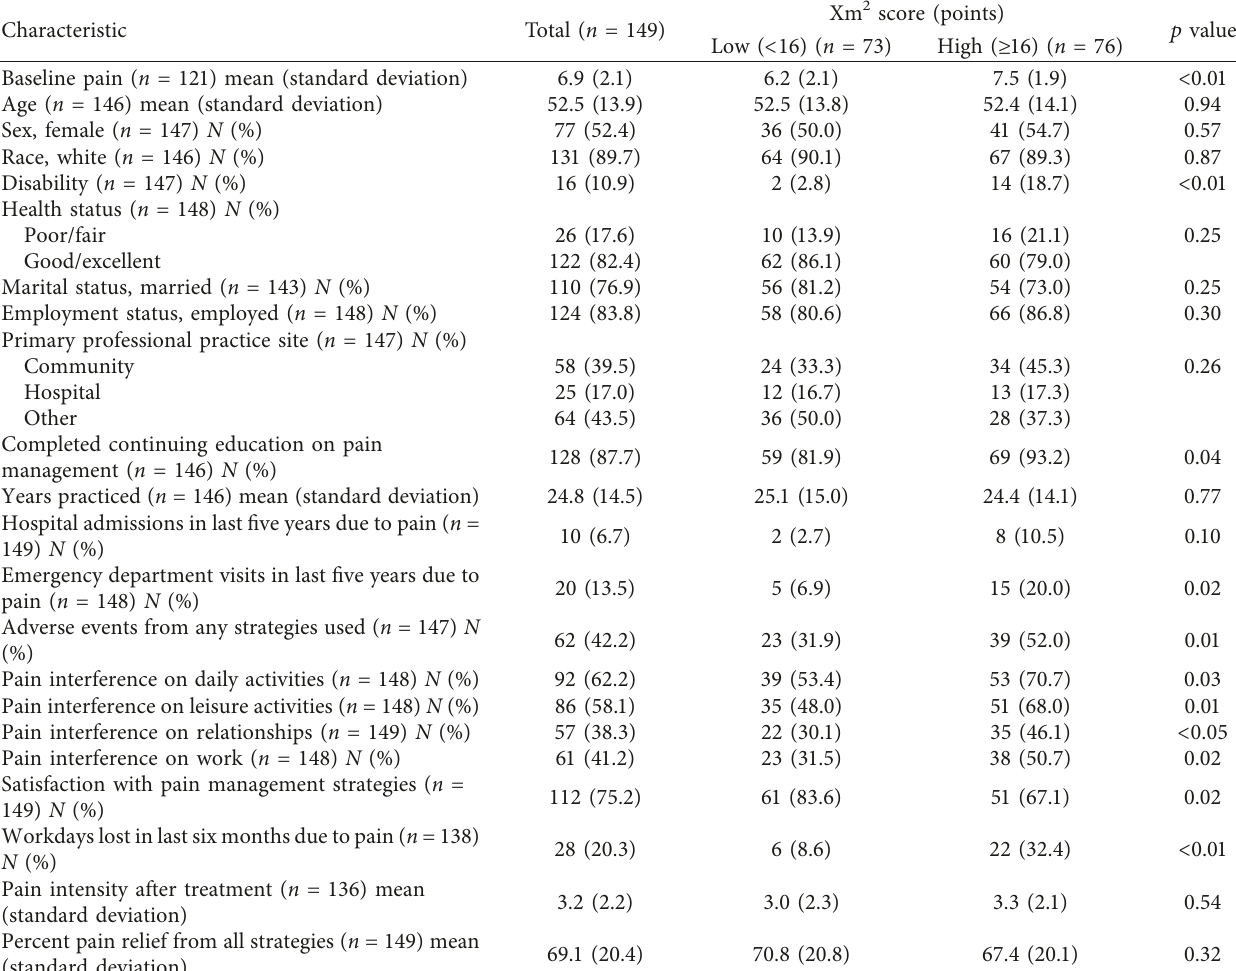
Table 1: Demographic characteristics and pain outcomes of study